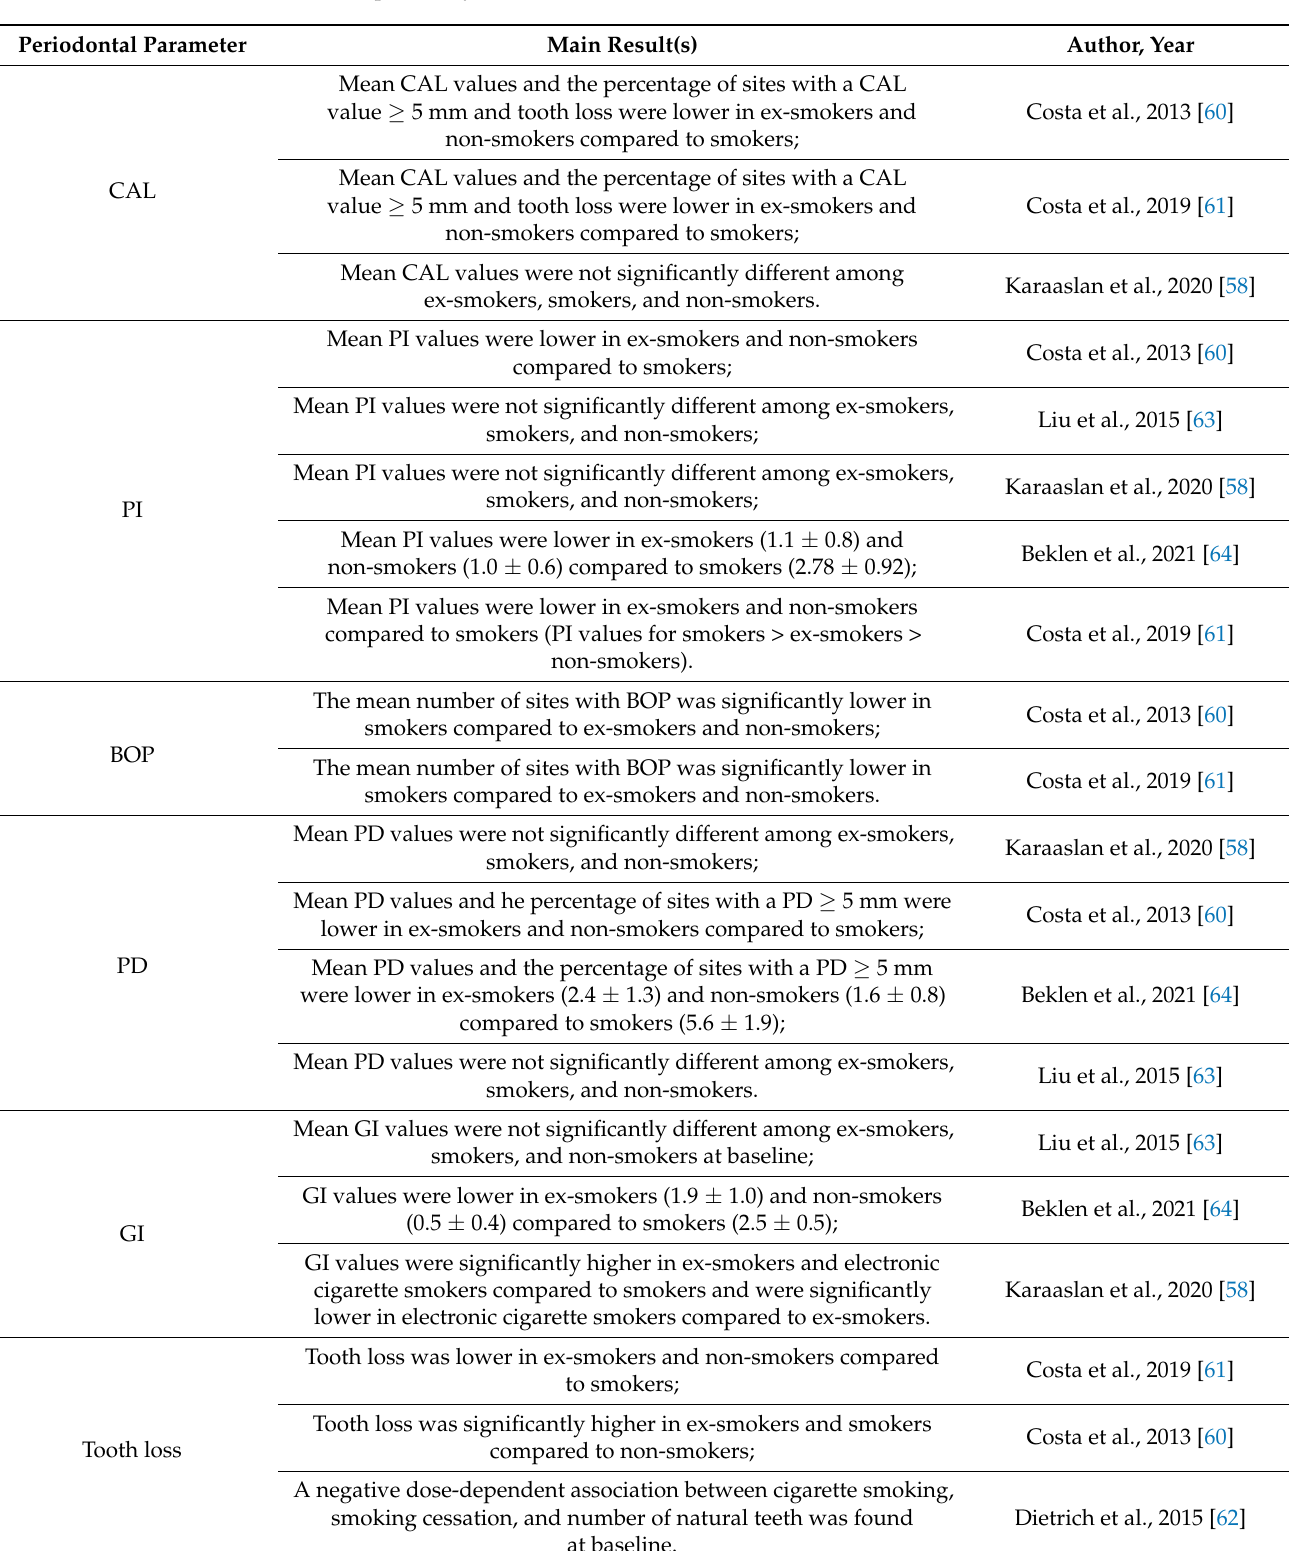
Table 3. Synthesis of the periodontal parameters around natural teeth reported in the studies included in the present systematic